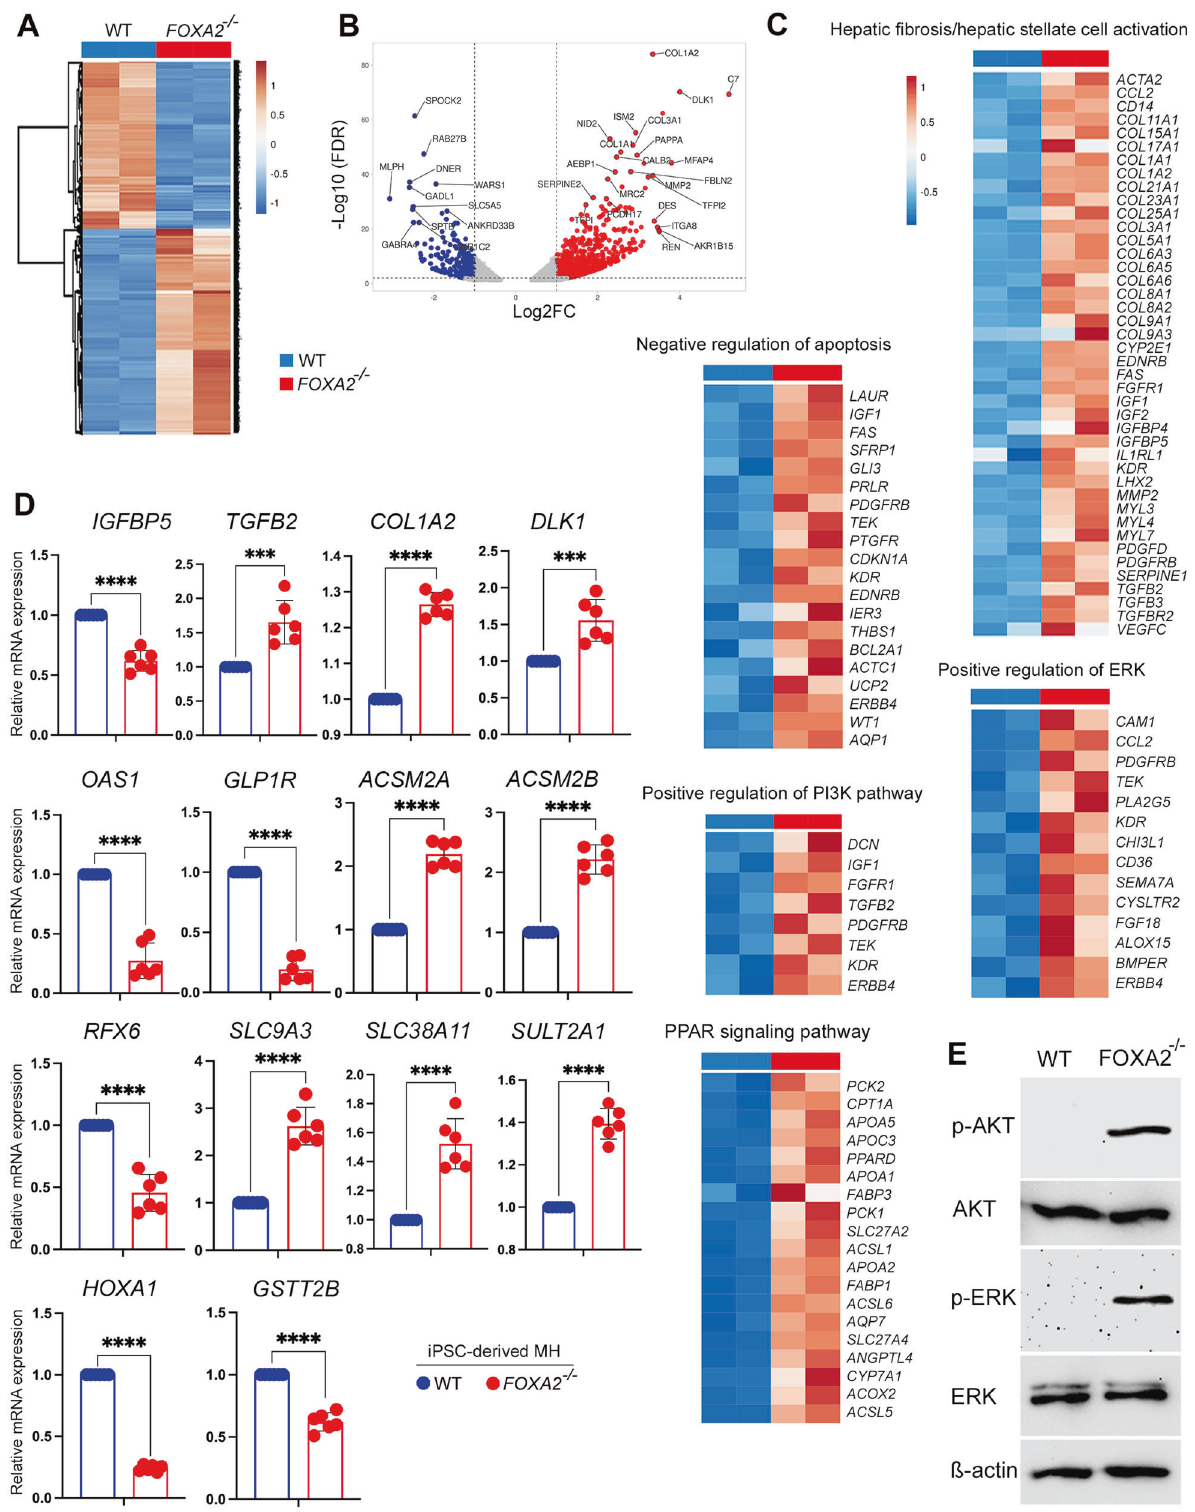
Fig. 6 RNA-seq analysis of mature hepatocytes derived from WT and FOXA2 − / − iPSCs. A A clustering heatmap of differentially expressed genes (DEG) in mature hepatocytes (MH) derived from WT and FOXA2 − / − iPSCs. B Volcano plot of the differential gene expression between WT and FOXA2 − / − MH (FDR < 0.05). Blue dots indicate downregulated genes, while red dots represent upregulated genes in FOXA2 − / − MH. C Heatmaps of the key pathway-associated DEGs in FOXA2 − / − MH compared to WT-MH ( p -value < 0.05 and Log2 FC > 1.0). D Validation of RNA-seq results using RT-qPCR for the upregulated and downregulated genes ( n = 6). E Western blotting of phosphorylated AKT (p-AKT) and phosphorylated ERK (p-ERK) showing a dramatic increase in p-AKT and p-ERK in FOXA2 − / − MH compared to WT-MH. Data are represented as mean ± SD; * p < 0.05, ** p < 0.01, *** p < 0.001.